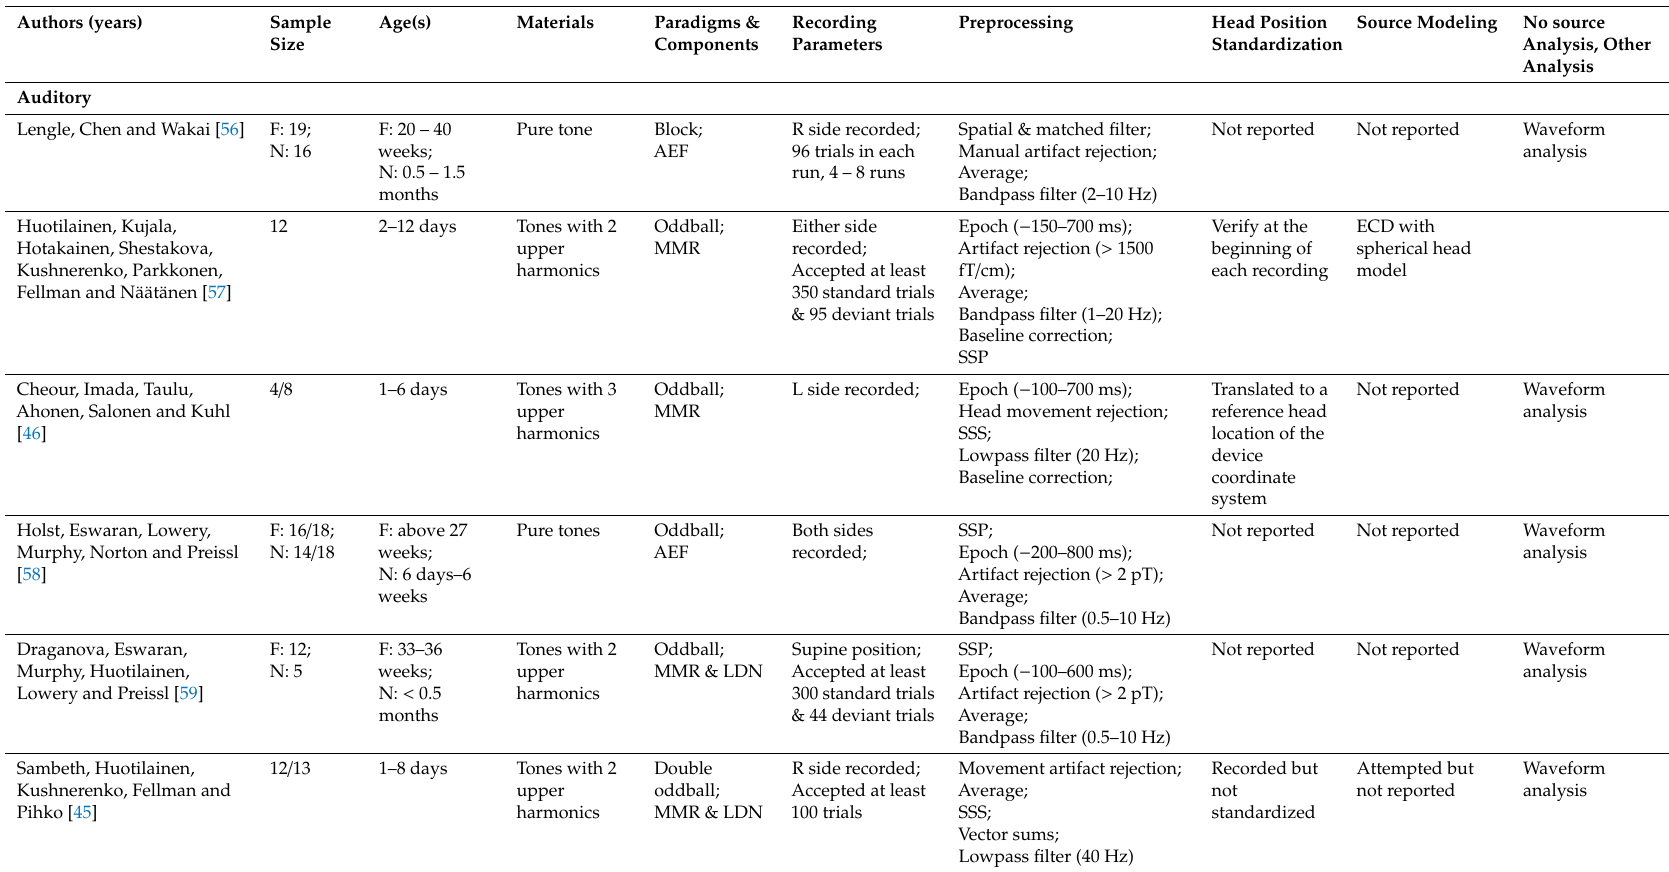
Table 1. A summary of the infant MEG papers